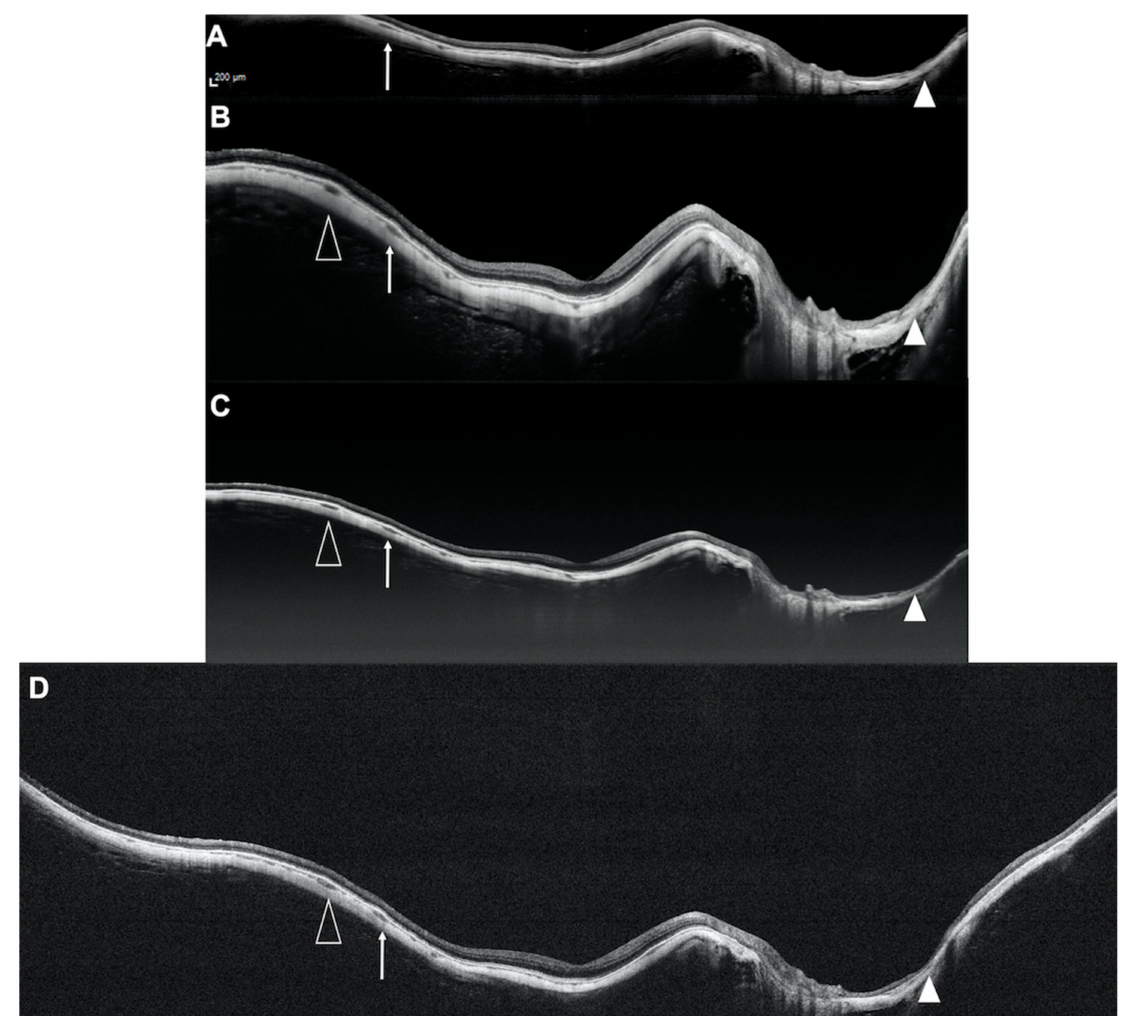
Figure 5. Representative example of a highly myopic eye imaged with four different optical coherence tomography devices. Spectralis OCT2 ( A ); Plex Elite 2.0 100 kHz ( B ); Plex Elite 2.0 200 kHz ( C ) and Canon Xephilio OCT-S1 ( D ). The arrowheads, the white arrowheads and the white arrows indicate the same structures in the different B-scans highlighting the different extent of retina visualized by the different